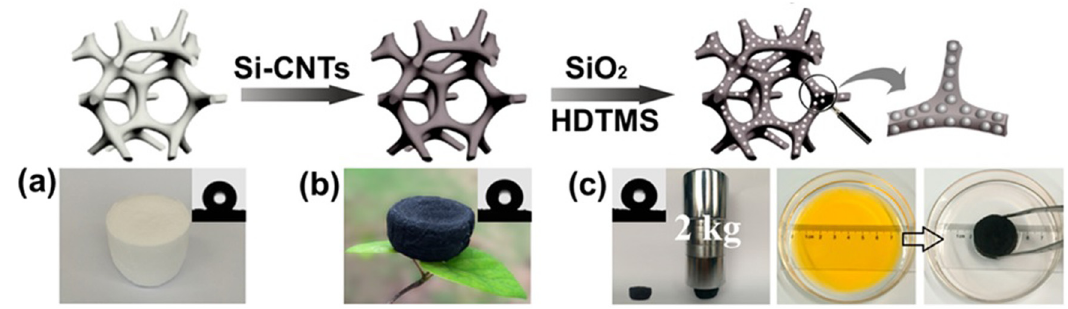
Figure 17: ( Top ) Schematic of the sponge preparation. ( Bottom ) Photographs/CAs corresponding to ( a ) cross - linked Et - cellulose sponge, ( b ) CNT - reinforced sponge, ( c ) load - bearing, and oil - absorption tests [ 197 ] . Reproduced with permission from ref. [ 197 ] ; © 2017 American Chemical